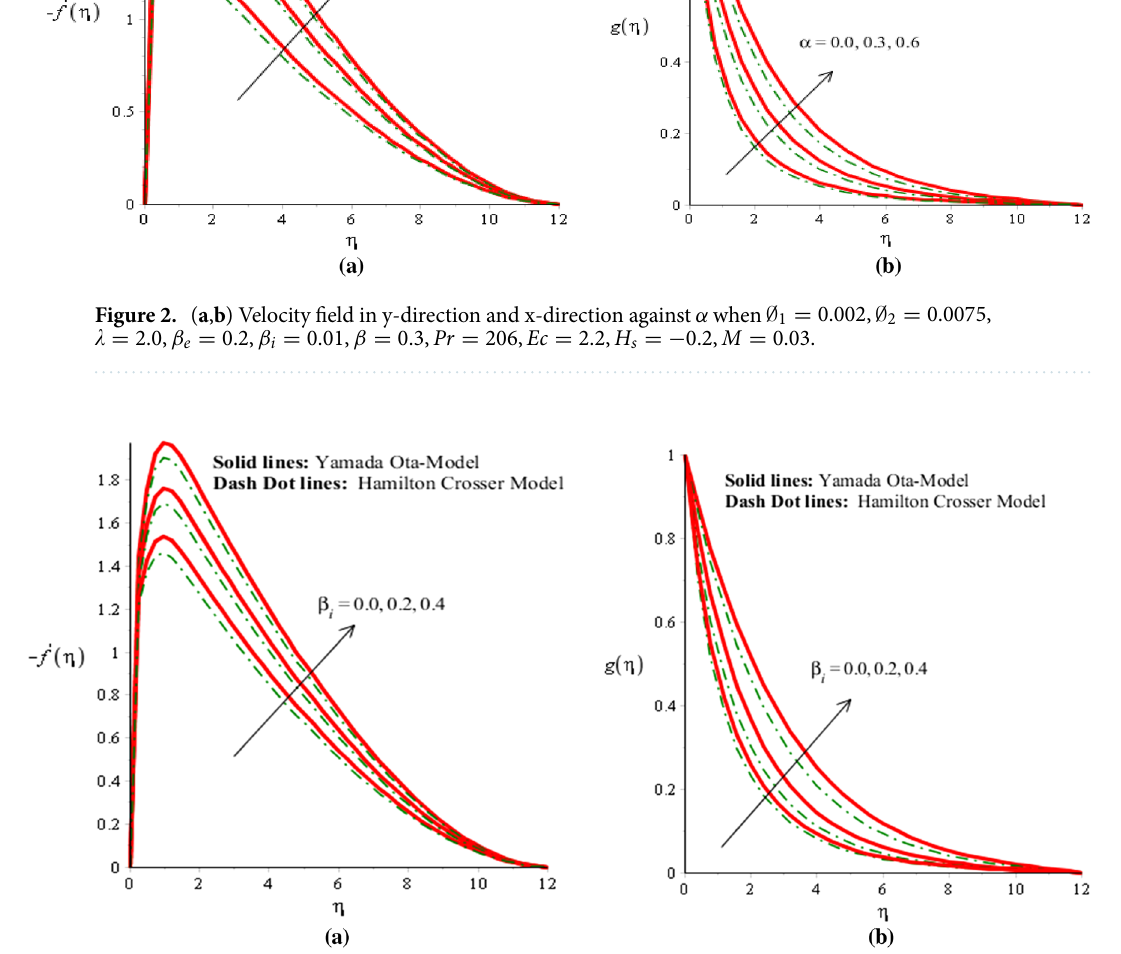
Figure 3. ( a , b ) Velocity field in y-direction and x-direction against β i when ∅ 1 = 0.002, ∅ 2 = 0.0075, (cid:31) = 0.3, β e = 2.0, α = 2.0, β = 00.2, Pr = 206, Ec = 3.0, H s = 2.0, M =